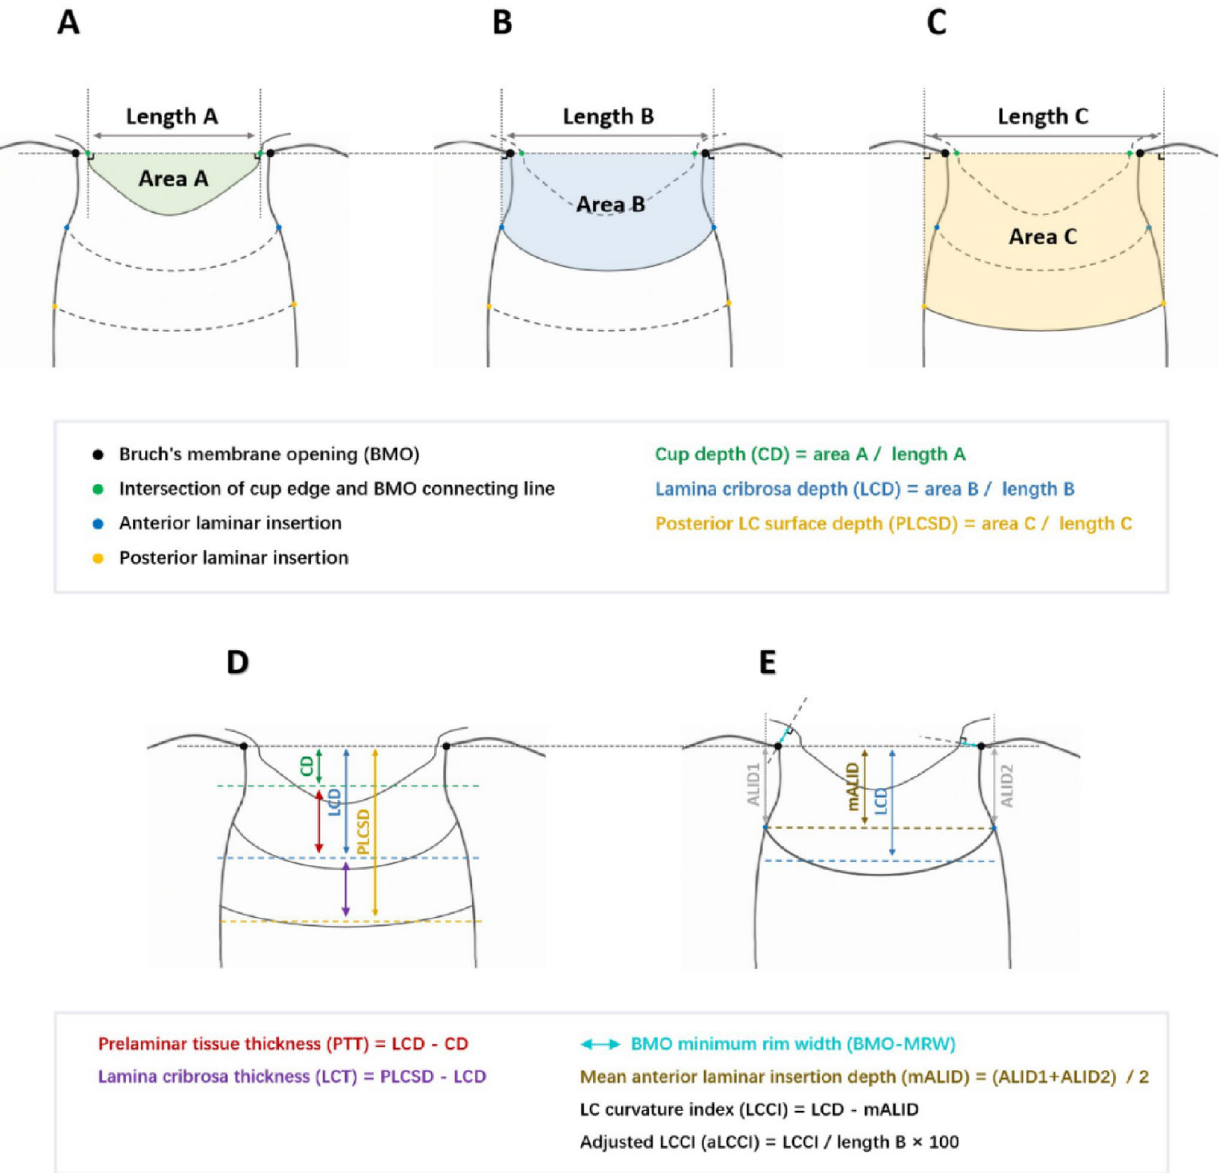
Figure 1. Examples of measurement methods of various lamina cribrosa related parameters. The three figures above showed the measurement of the three depth indicators (CD, LCD, PLCSD). Their calculation methods are similar. They all approximate the depth index by making two vertical lines perpendicular to the BMO line, calculating the middle area (colored area in the figure) and dividing by the length of the bottom edge. The two figures below showed the measurement of other screening parameters. The thickness index is obtained by subtracting the depth index calculated at the front edge. BMO-MRW refers to the shortest vertical distance between BMO and ILM, ALID refers to the vertical distance from lamina cribrosa edge to BMO line, and LCCI refers to the difference between average ALID and LCD on both sides. aLCCI is defined as LCCI divided by the length of bottom edge, which can exclude the mixed effect of BMO opening width on